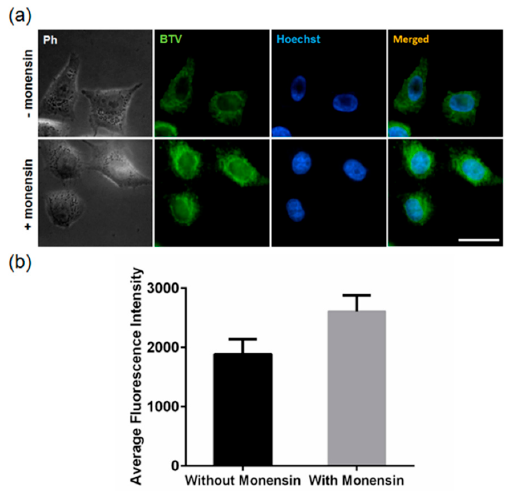
Figure 5. ( a ) Fluorescence intensity measurement of BTV -treated (1 µM) HeLa cells before and after incubation with 10 µM monensin for 30 min. Images were taken with a 40× objective. Scale bar represents 50 µm; ( b ) Fluorescence intensities were displayed as averages of measurements from twelve sites taken across three wells. * p < 0.005.